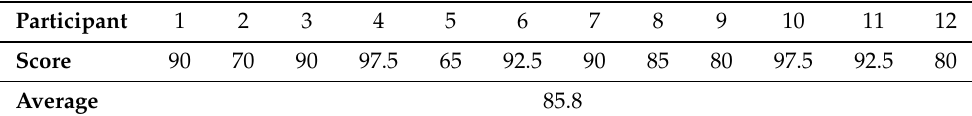
Table 9. System Usability Scale (SUS)